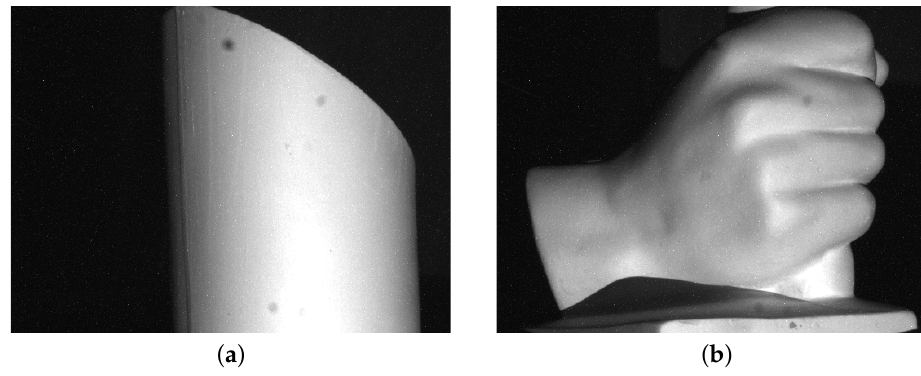
Figure 6. Detected targets. ( a ) Cylinder and ( b ) hand plaster models.